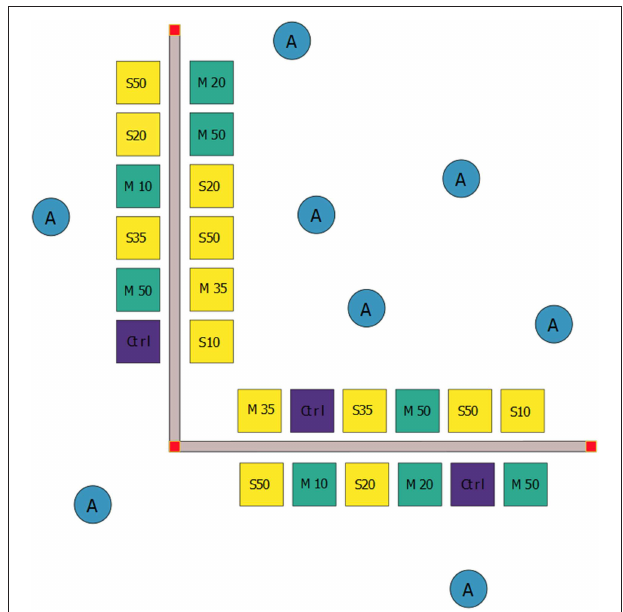
FIGURE 1 | Schematic diagram of the design and set-up of the field experiment showing the random allocation of treatments to 1 m 2 experimental plots: live Sabella spallanzanii worms (S, yellow squares), mimic S. spallanzanii worms (M, green squares) and controls (Ctrl, purple squares) without worms. Live and mimic worms were transplanted at four different densities (i.e., 10, 20, 35, and 50 worms (or mimics) per plot). Additionally, eight ambient samples (A, blue circles) were collected from adjacent uninvaded areas as procedural